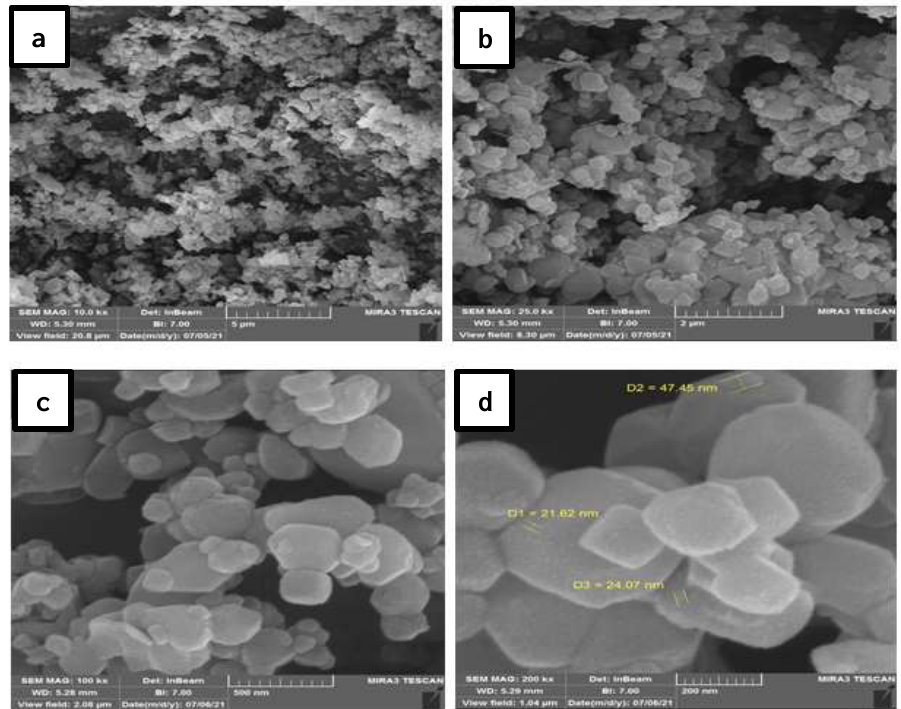
Figure 5: FE - SEM images of the synthesized MgO nanoparticles synthesized using extract where the scale bar is a) 5um, b) 2um, c) 500 nm, and d) 200